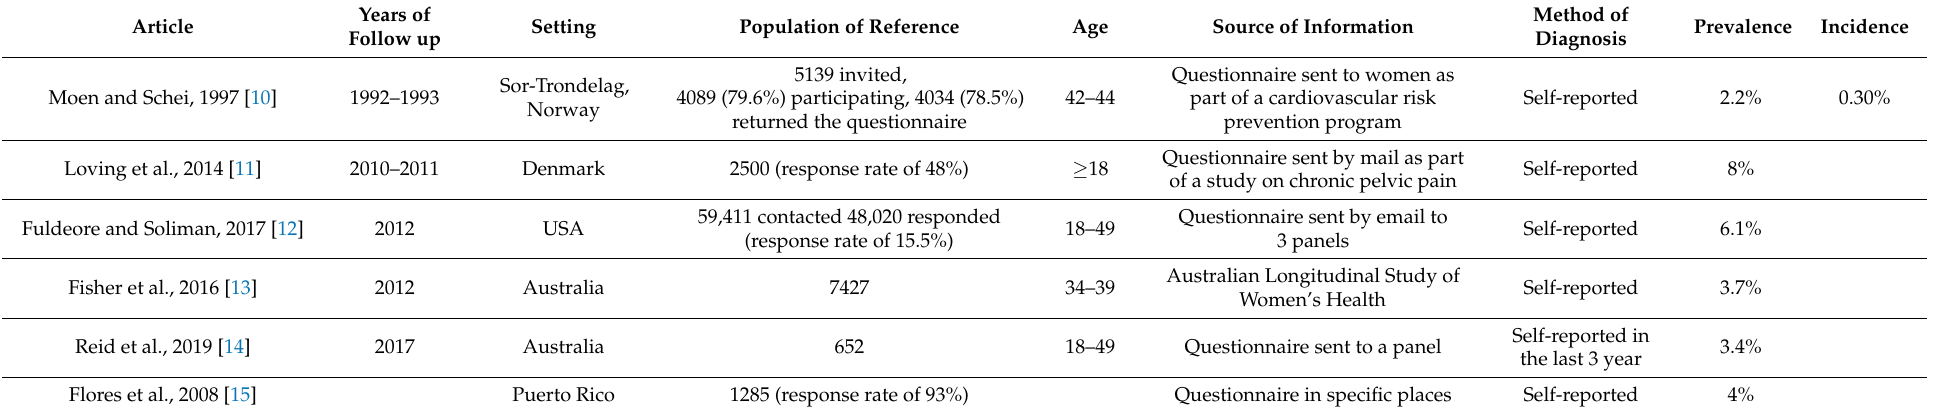
Table 1. Questionnaires and self-reported data.